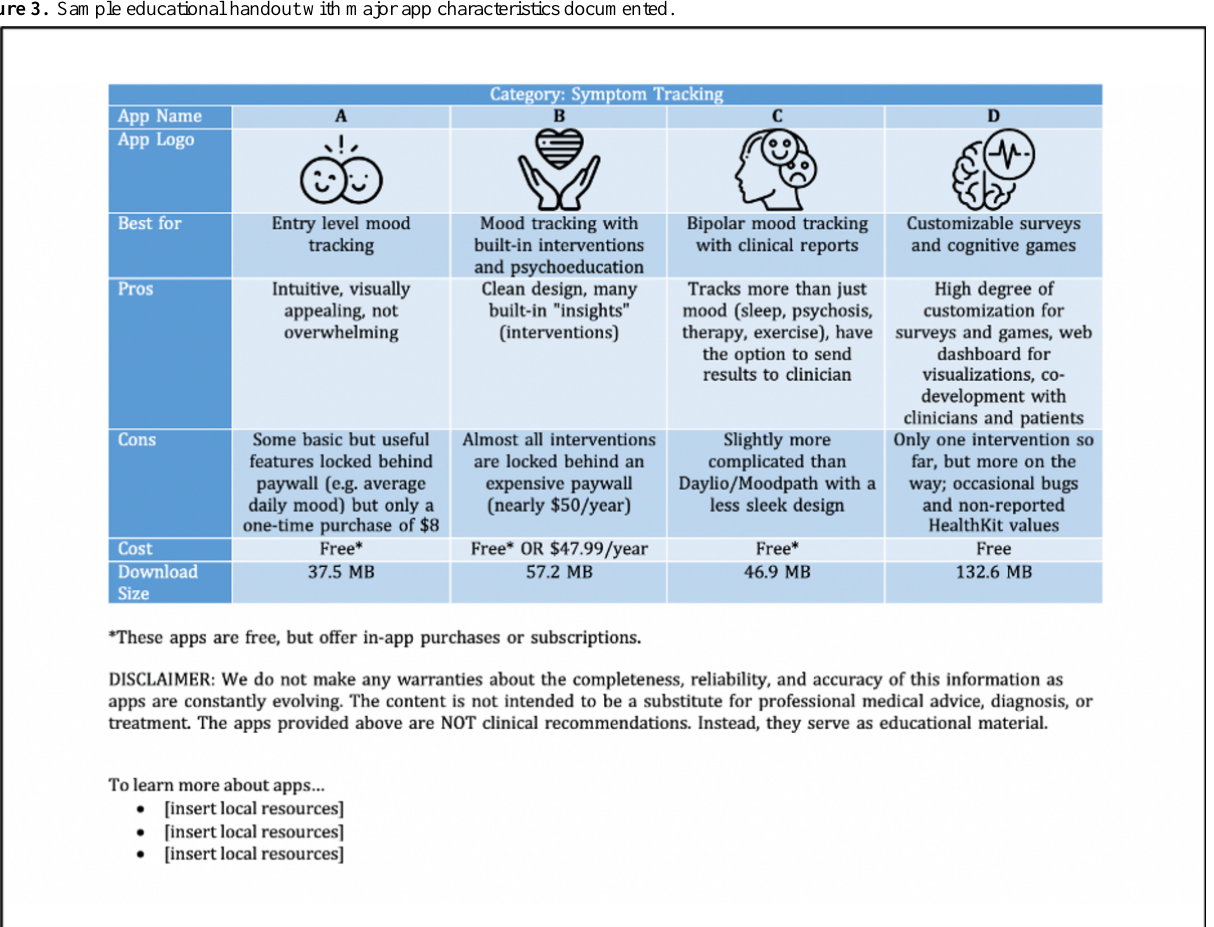
Figure 3. Sample educational handout with major app characteristics